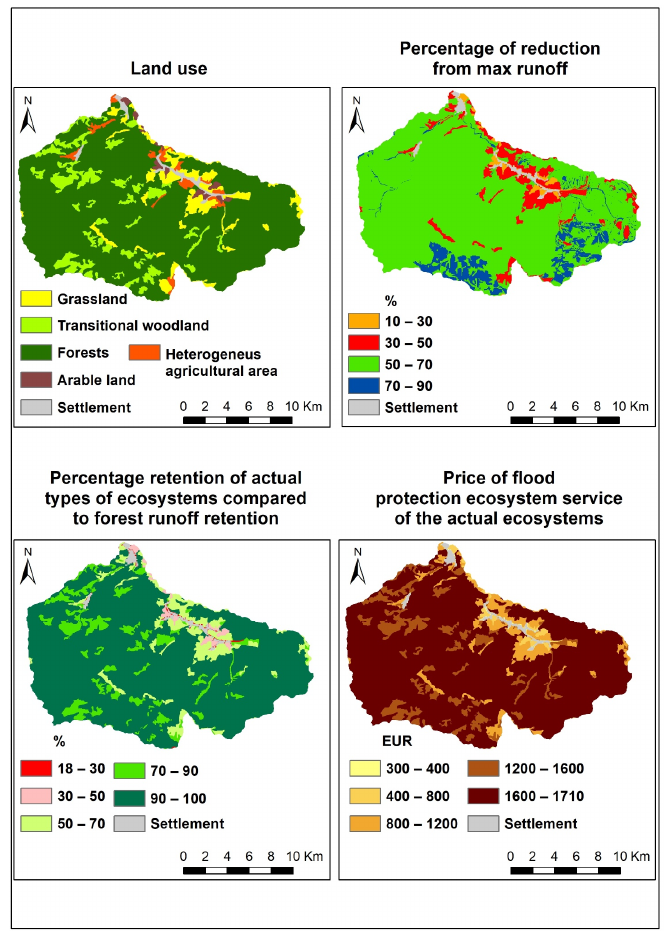
Figure 8. Current land use and the assessment of its flood protection ecosystem service.